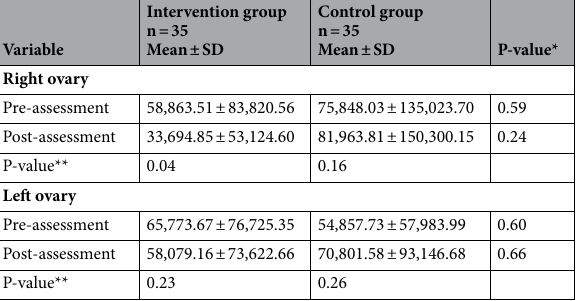
Table 6. Comparison of the ovaries’ volume between intervention and control groups. *T-test was carried out for comparison of the groups. **Paired T-test was carried out for comparison of changes between the